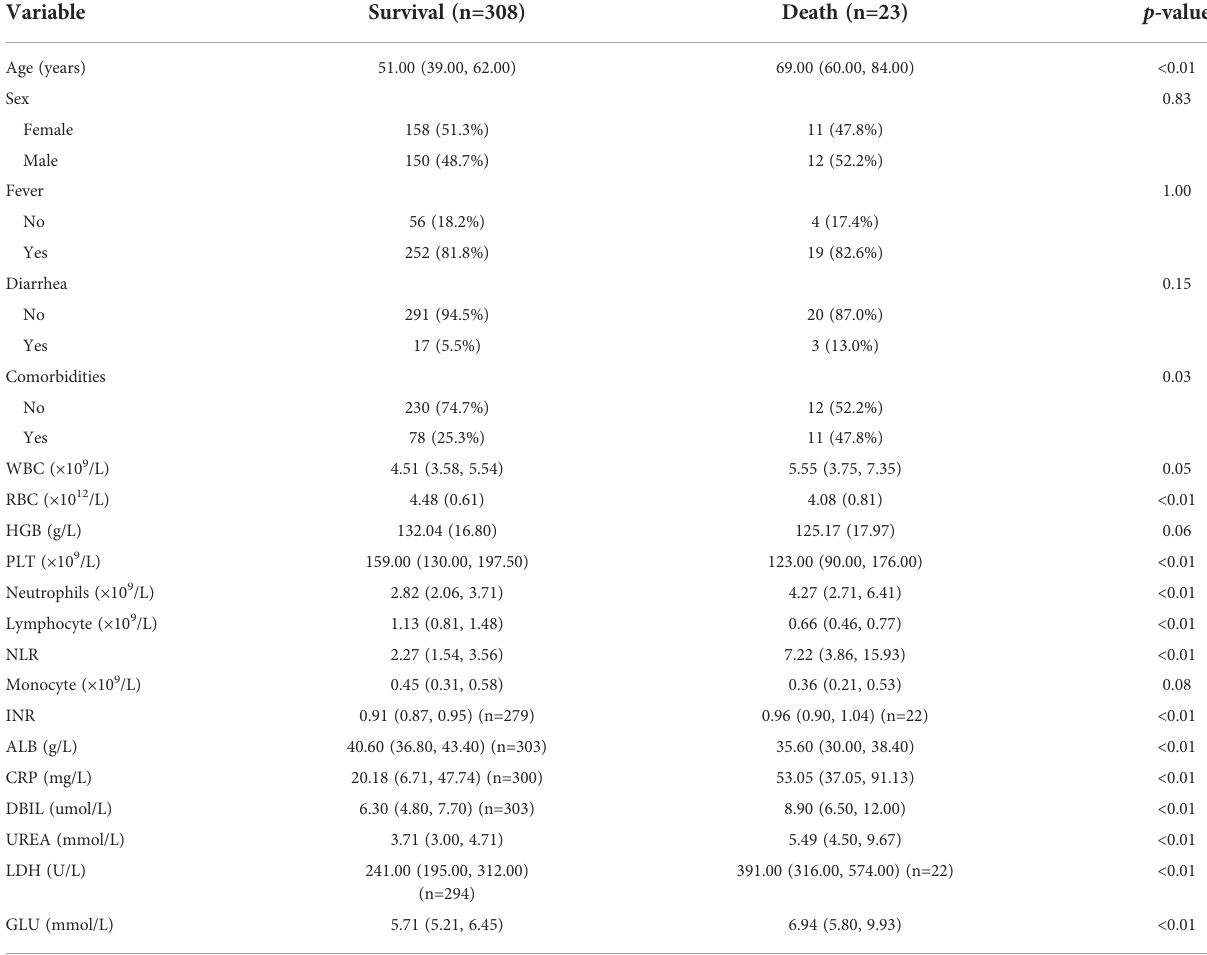
TABLE 1 Baseline demographic and clinical characteristics of COVID-19 patients in Survival and Death groups.